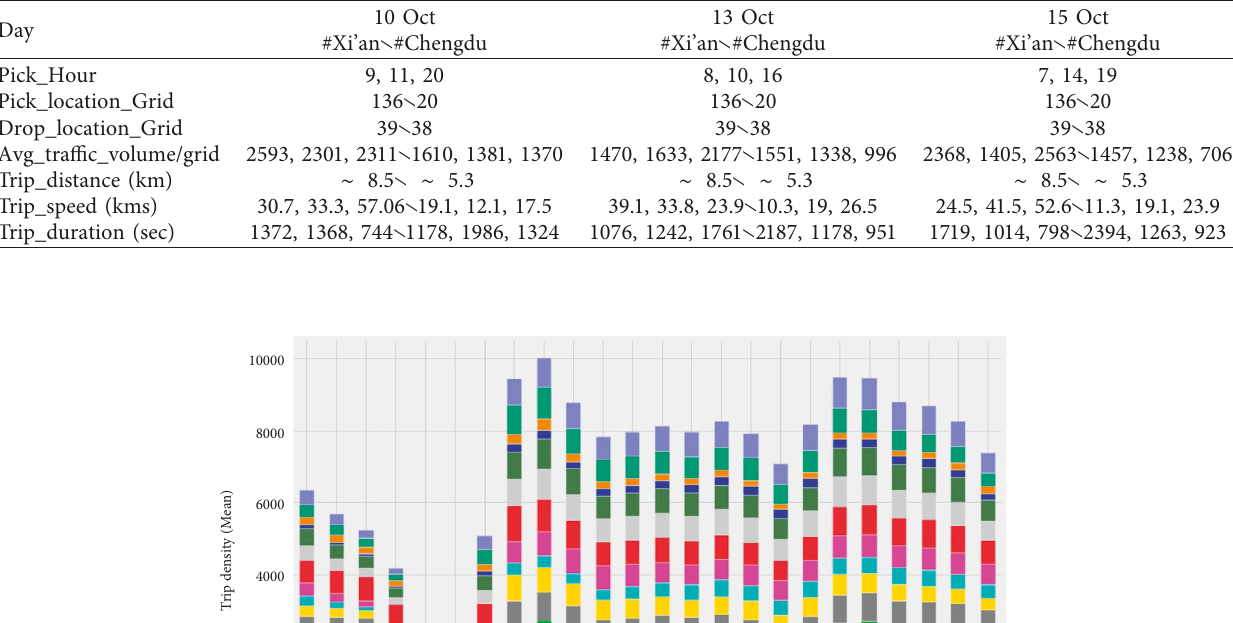
Table 1: Statistical analysis of the traffic patterns and fluctuations in particular locations in Xi’an and Chengdu cities.